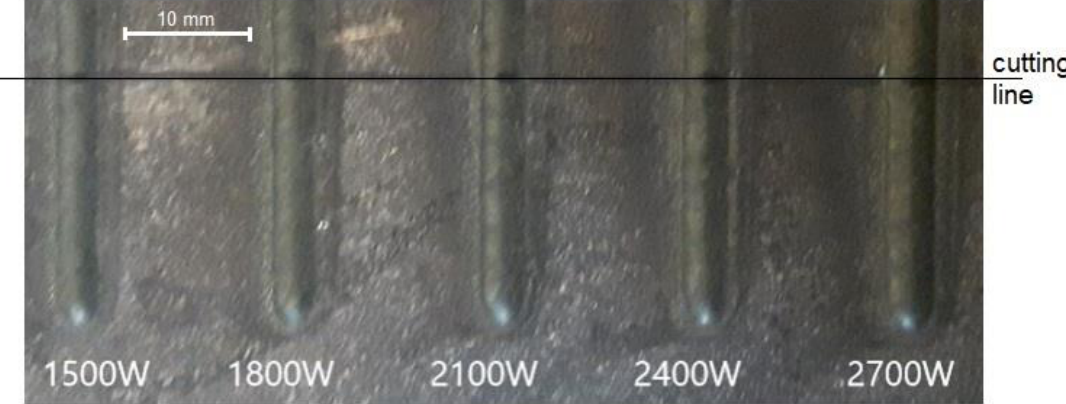
Figure 4. Macroscopic morphology of coatings prepared by ring beam of single bead coatings at a feeding rate of 5 rpm, laser power was changed from 1500 W up to 2700 W.